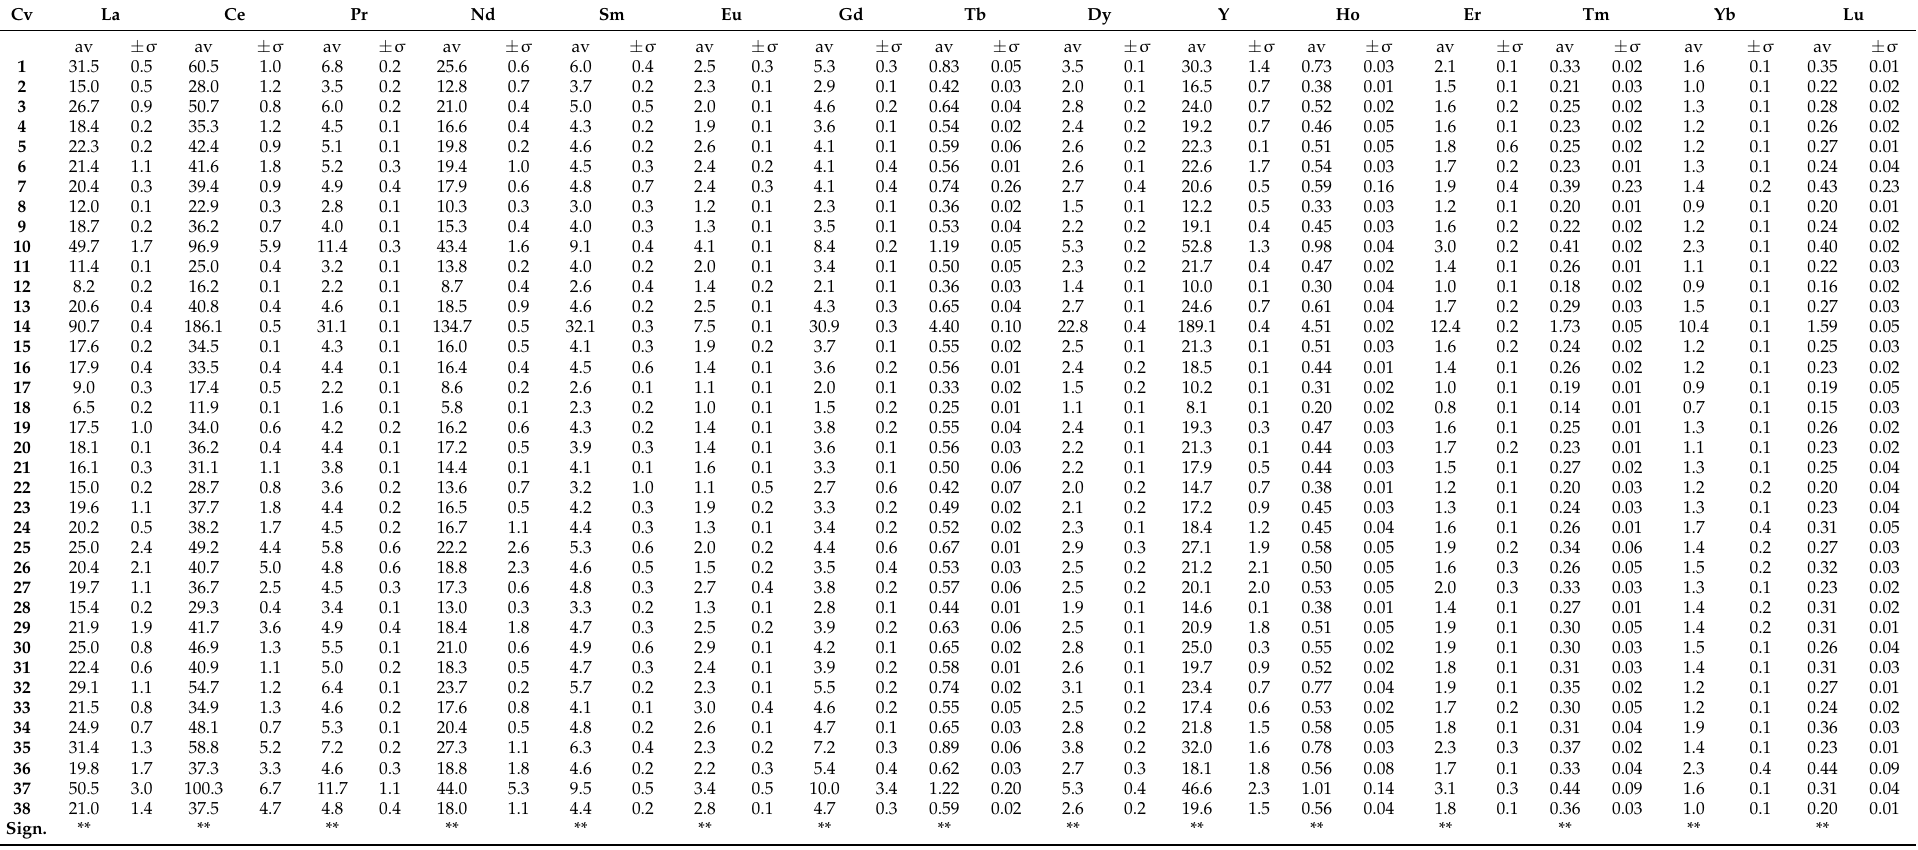
Table 2. Concentrations of REE, from analysis for each olive pulp cultivar (Table 1), averaged values with standard deviations, in nmoles Kg − 1 (** = p ≤